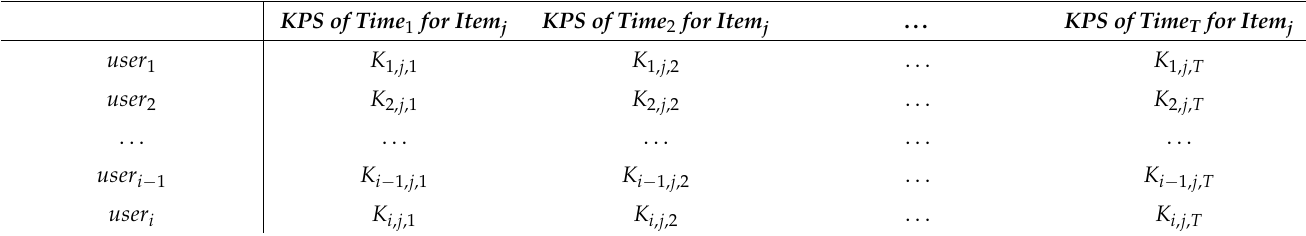
Table 5. Keypoint score on each time for item j .